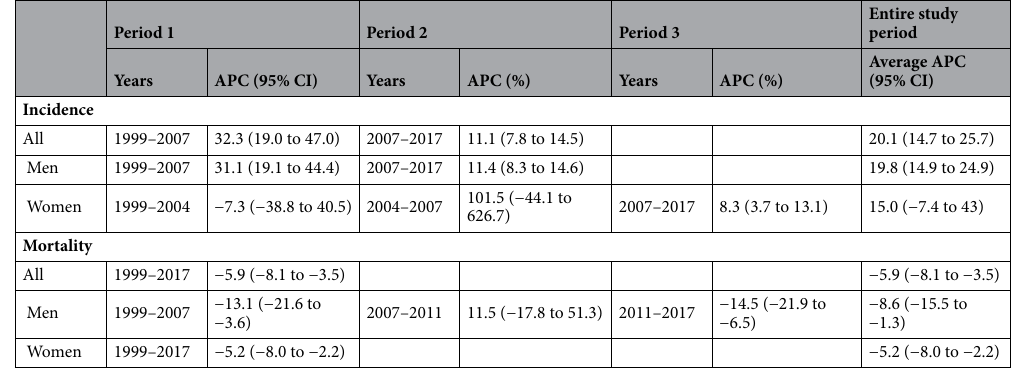
Table 2. Trend analysis in crude rates of the incidence and mortality of legionellosis per 100,000 population by sex, 1999–2017. APC annual percentage change, CI confidence interval.